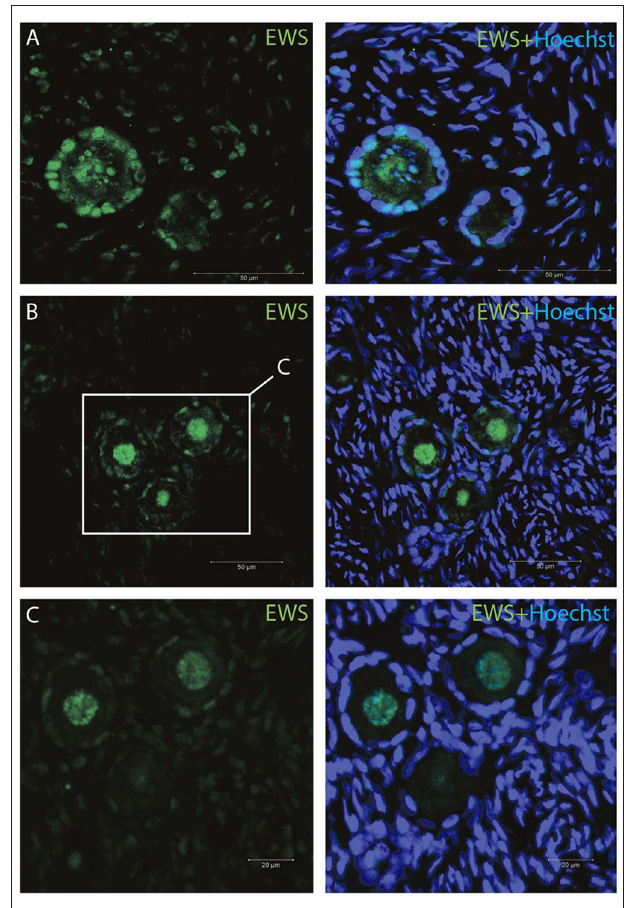
FIGURE 4 | Intra-ovarian distribution of EWS in human primordial and primary follicles (A-C) . EWS is present in both oocytes and the surrounding granulosa cells in primordial and primary follicles. Hoechst staining identifies the nucleus of cells. Scale bars; 30 µ m.